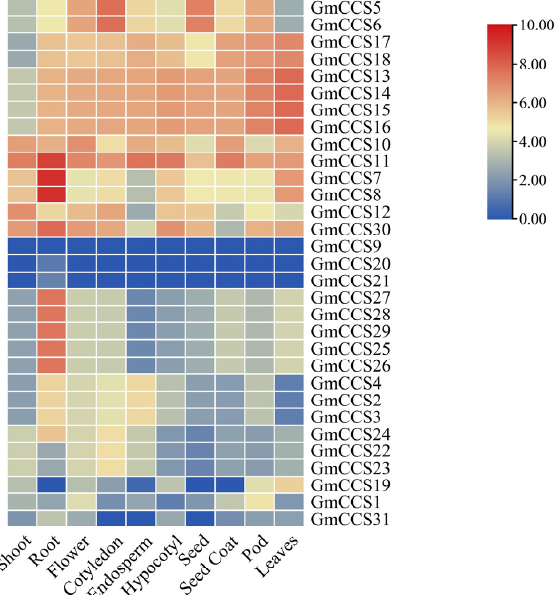
Figure 6. Heat map of expression profiles (in log2-based FPKM) of soybean GmCCS subgroup genes in different tissues (root, root hairs, stem, leaf, nodules, flower and seed). The gene names are on the left and the tissue names are on the top of the figure, and the expression abundance of each transcript is represented by the color bar: Red, higher expression; blue, lower expression.